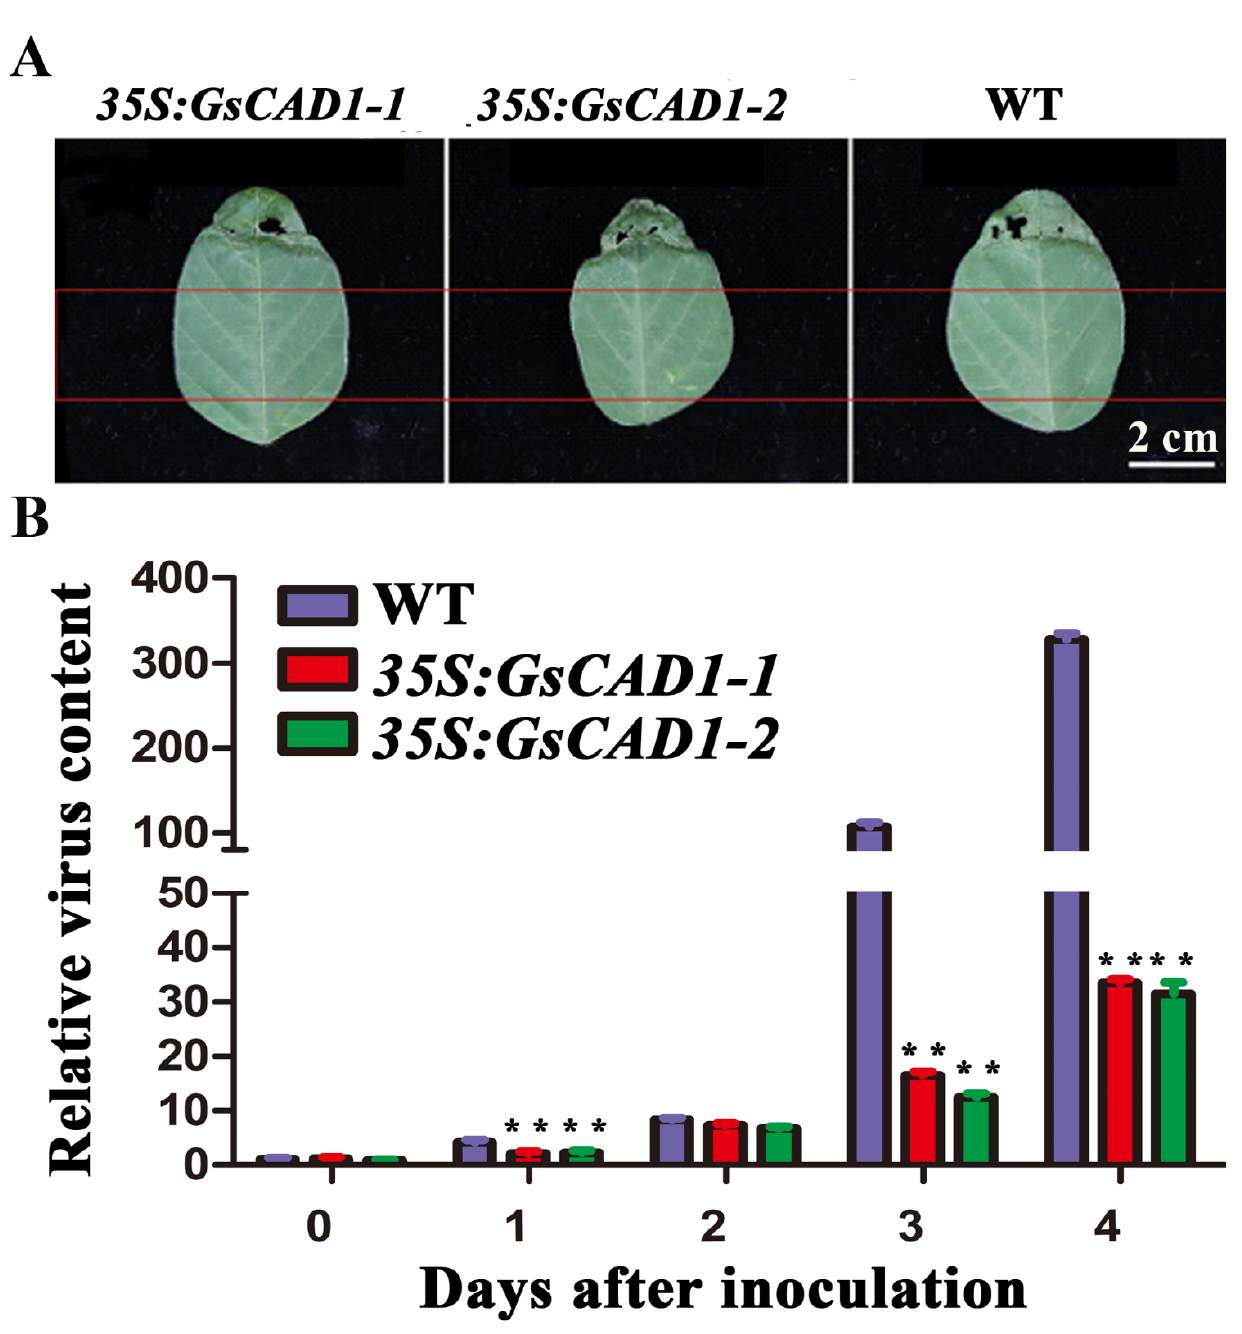
Figure 5. GsCAD1 -overexpression affected the accumulation of SMV in soybean leaves. ( A ) The first trifoliate leaves of 14-day-old wild-type and 35S:GsCAD1 transgenic plants were inoculated with virus. Leaf sections below the inoculation sites (between the two lines) were collected 1, 2, 3 and 4 days, respectively, after inoculation. Total RNA was isolate and qRT-PCR was used to examine virus RNA. ( B ) Virus content in the wild-type and 35S:GsCAD1 transgenic plants at 1, 2, 3 and 4 days, respectively, after inoculation ( CP gene). Data represent the mean ± SD of three independent experiments at 35 days of SMV inoculation, with each experiment consisting of three technical replicates. The asterisks in each panel represent significant differences in virus content between WT and OE lines (Student’s t -test, **, p < 0.01).